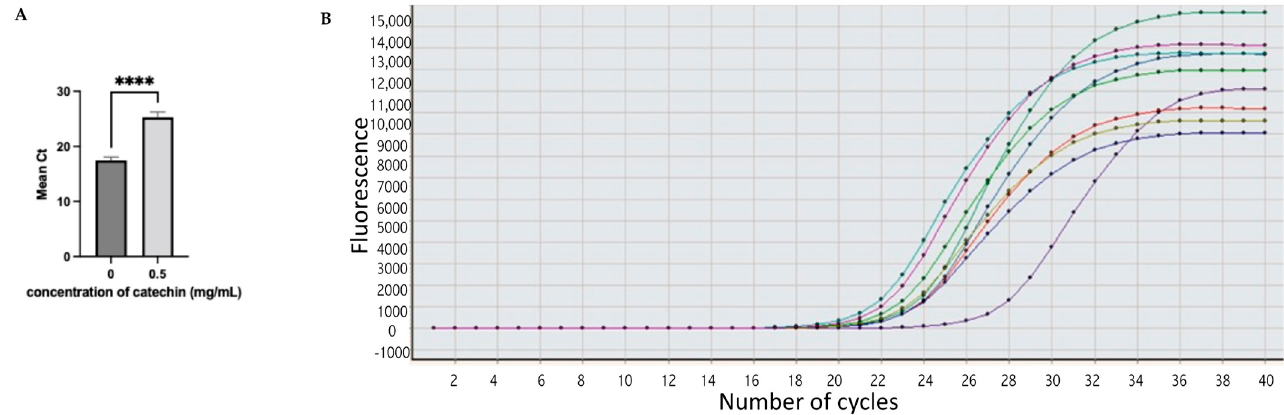
Figure 4. Expression of acrA gene in E. coli clinical isolates. ( A ) The level of expression without catechin treatment and with catechin treatment at concentration = 0.5 mg/mL. ( B ) The level of acrA expression in nine isolates represented in colored lines after catechin treatment. Data were expressed as mean ± SD with significant level **** p < 0.001. Table 4. The expression level of the 16S rRNA and acrA genes in E. coli clinical isolates.